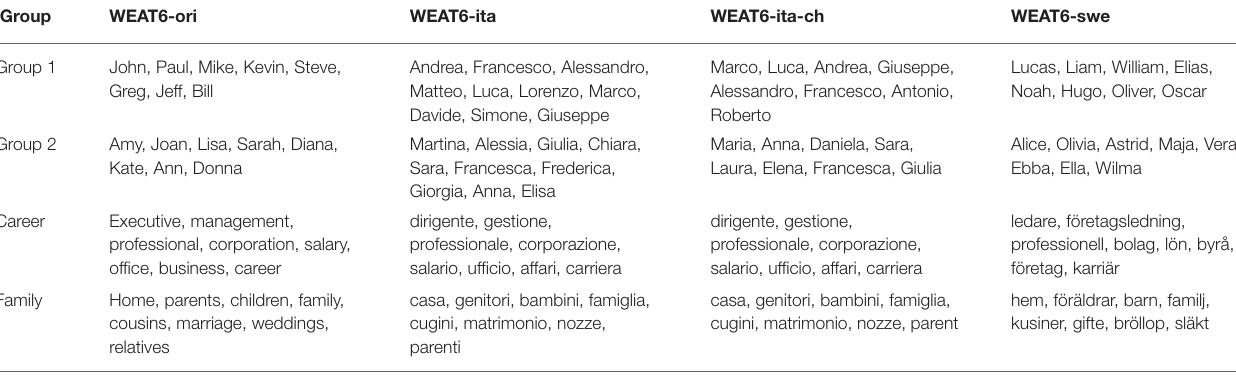
For Italian, a Swiss and an Italian version of the experiment was used.